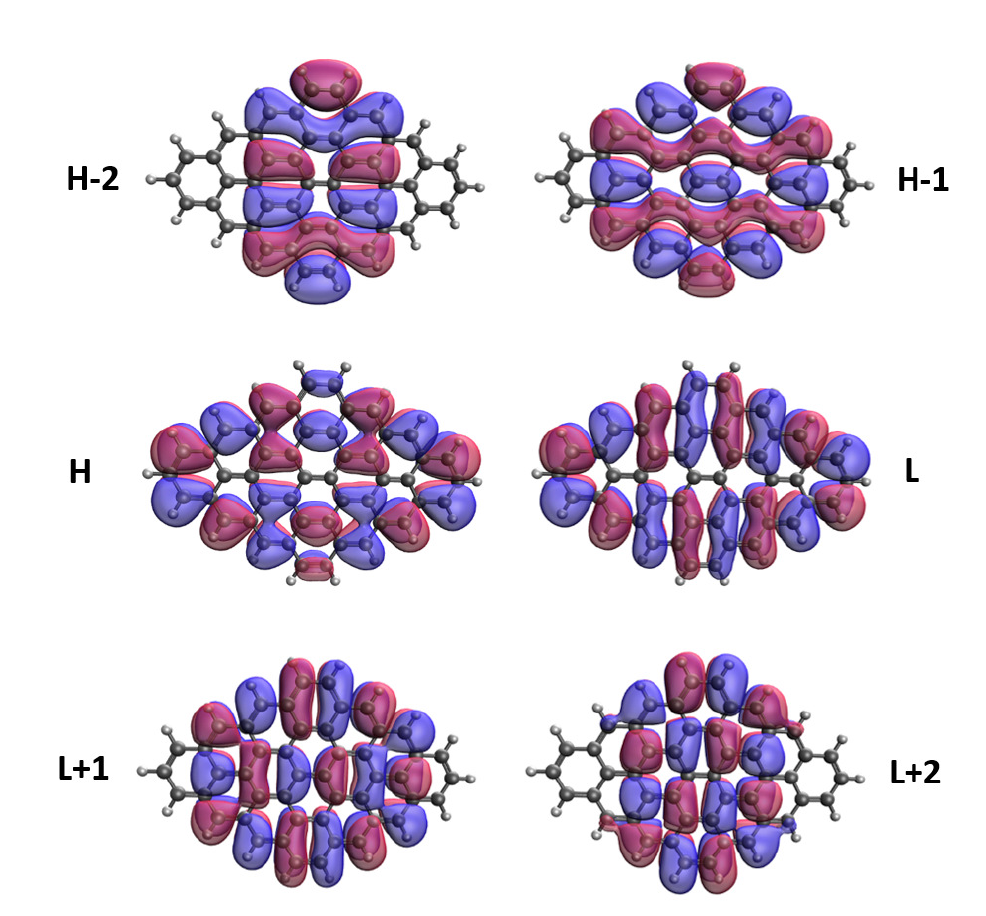
Figure 9. Real-space representation of H − 2 (2.000), H − 1 (1.976), H (1.669), L (0.334), L+1 (0.021), and L+2 (0.000) of ground-state 4-pyrene, calculated by spin-restricted TAO-LDA. Here the isovalue is 0.02 e/Å 3 . The occupation numbers of active orbitals are given in parentheses, and HOMO/LUMO is denoted as H/L for